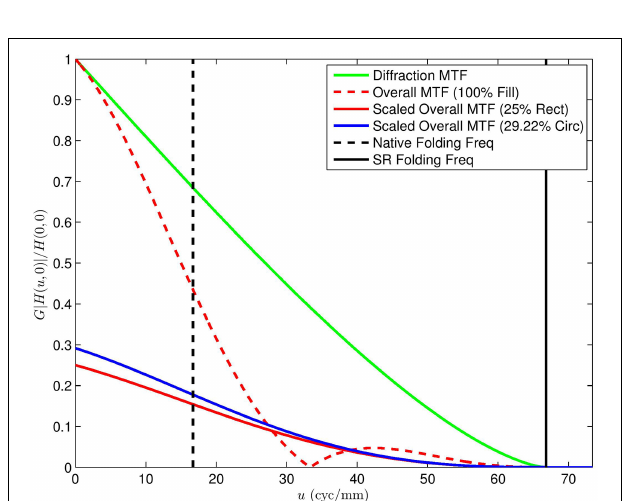
FIGURE 15 | Cross-section of the MTF for Figure 12 scaled by the detector Gain from Figure 14. Here one can compare the overall system MTF employing a 100% fill factor with a gain adjusted MTF for the systems with the detector zeros shifted out to the optical cutoff frequency. Note that even though the gain is much lower, the overall transfer function for the frequency band between 30 and 40 cyc/mm is higher using the smaller detectors, because of the detector